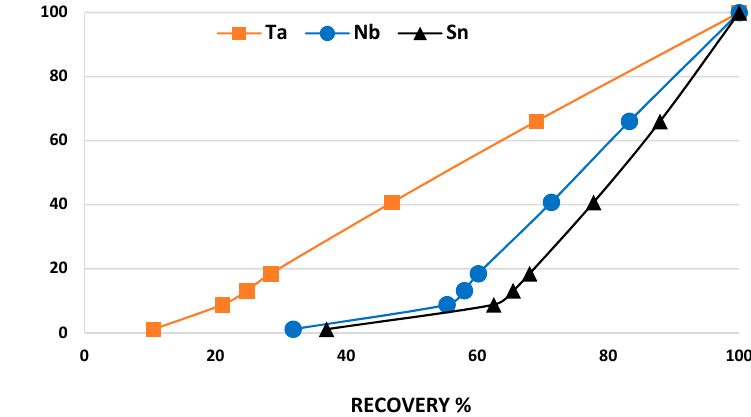
Figure 20. Mass pull (%) and recovery (%) for Wilfley shaking table cleaner test on Penouta sample, measured using PXRF.